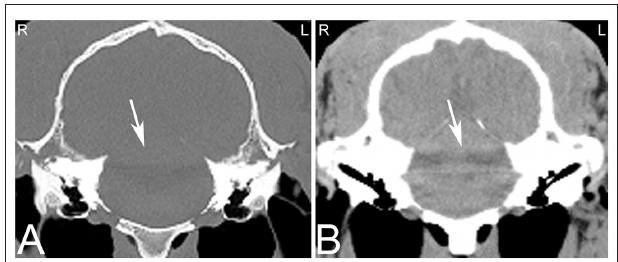
FIGURE 1 | Beam hardening artifact. Transverse computed tomography images of the head at the level of the petrous bone in a bone (A) and soft tissue (B) window. The beam hardening artifact can be noted as hypoattenuating streaks (white arrows) next to areas of high attenuation such as the petrous bone of the skull. L, left; R,